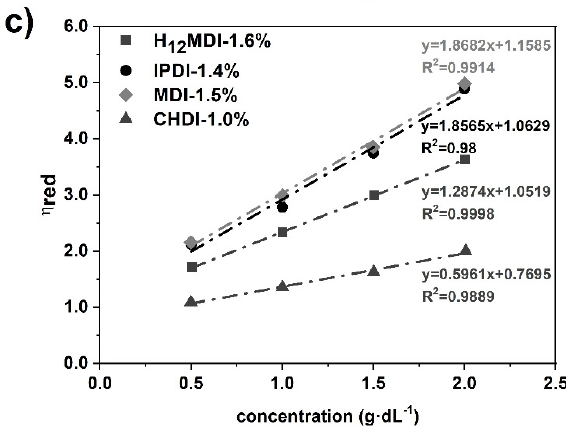
Figure A2. Huggins plots of reduced viscosity ( η red. ) versus concentration (g · dL − 1 ) of four PSU solutions in THF. The intrinsic viscosity [ η ] was calculated by extrapolation of the Huggins fitting curves. ( a ) Huggins plots of the PSU H 12 MDI elastomers comprising HS contents between 5% and 20%. A linear fitting curve was only obtained for the elastomer comprising 5% HS content. Values of reduced viscosity of the PSU H 12 MDI elastomers containing higher HS contents behaved not linear and seemed to rather follow an exponential trend. ( b ) Huggins plots of the PSU IPDI elastomers containing HS contents between 5% and 20%. ( c ) Huggins plots of PSU copolymers that were synthesized without chain extender.